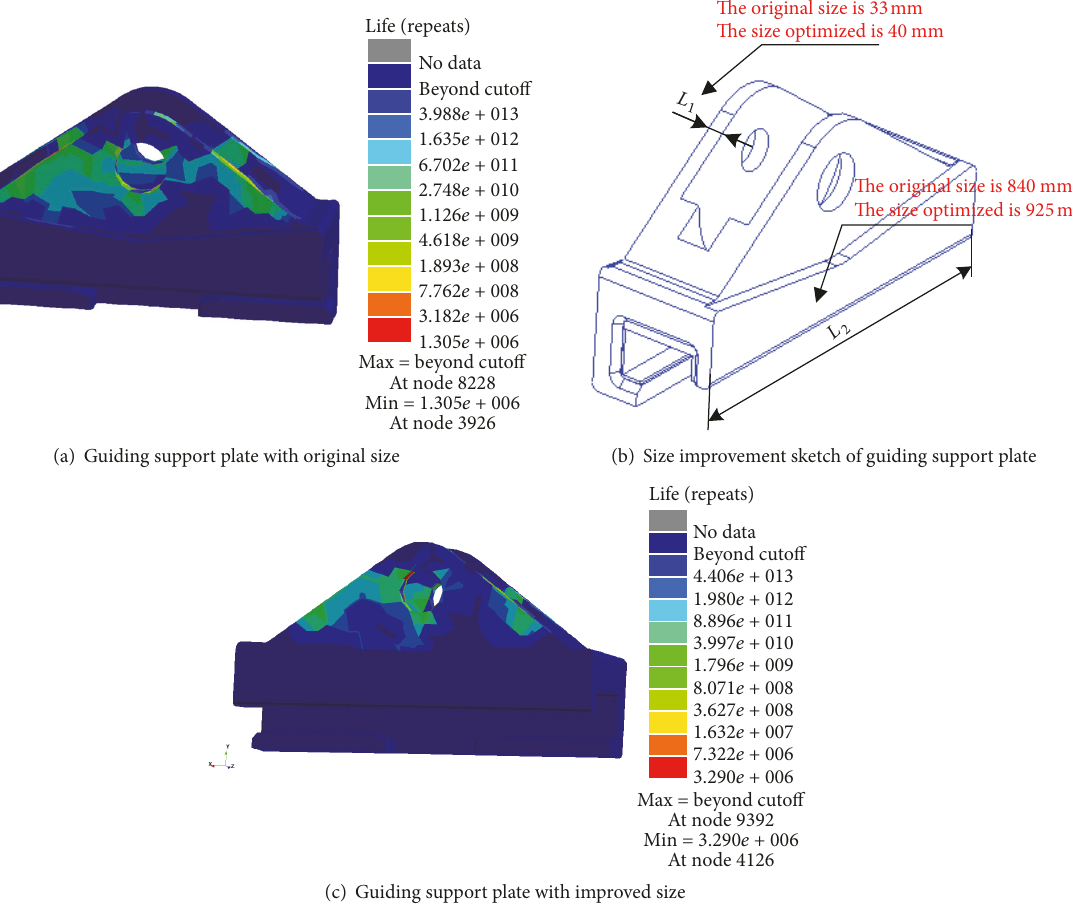
Figure 12: Lifetime analysis and comparison for guiding support